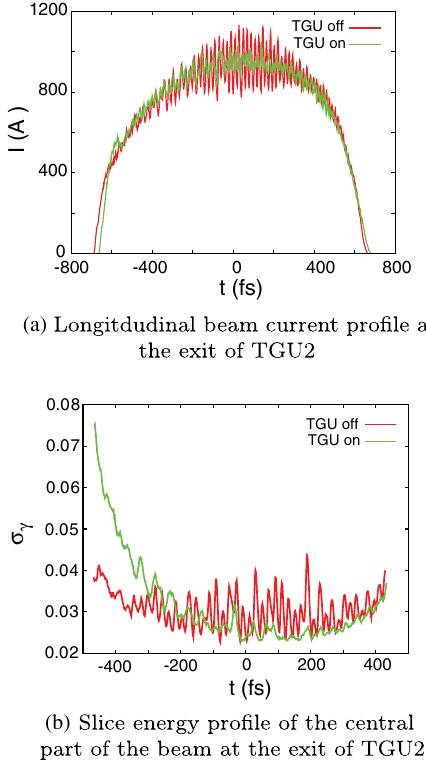
FIG. 4. Longitudinal beam current and slice energy profile at the exit of TGU2 with TGUs on (green) and off (red).